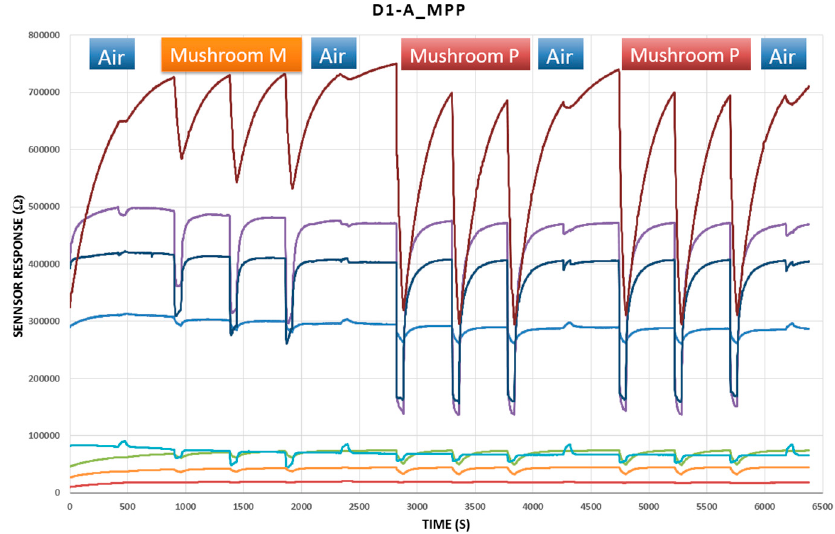
Figure 3. Curve of the response of the sensors to the D1-A_MPP triangle test.